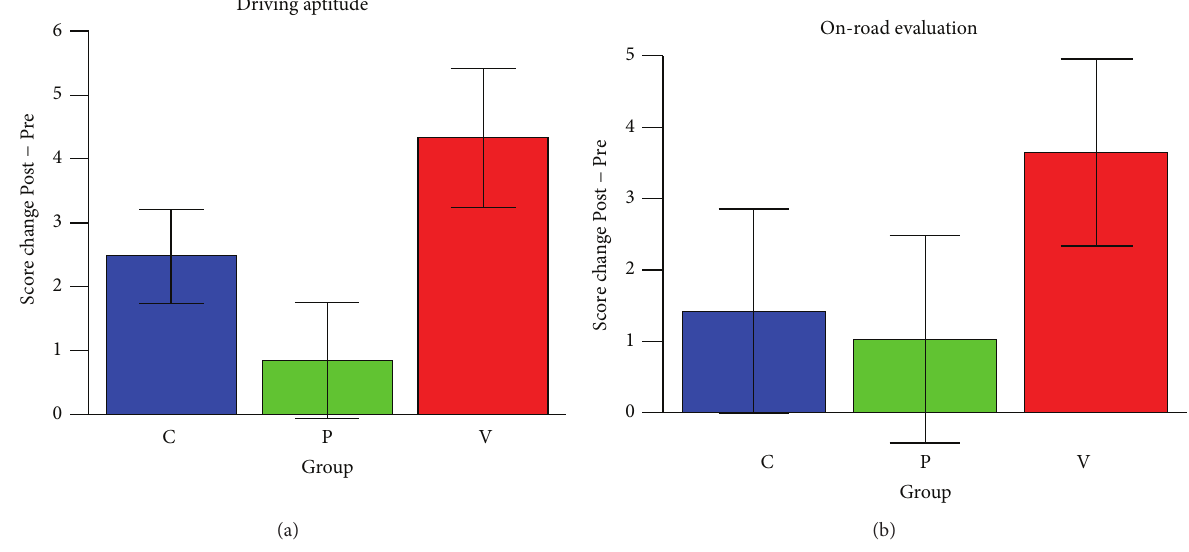
Figure 6: Changes in driving safety measures in each training group. The measures are as follows: (a) the total grades obtained from the driving aptitude test unit and (b) the total grades obtained from the on-road driving safety test. The score changes were adjusted for age, sex, and Pre (baseline) scores. The error bars in the graphs show the standard errors of the mean (SEM) of the subjects in each